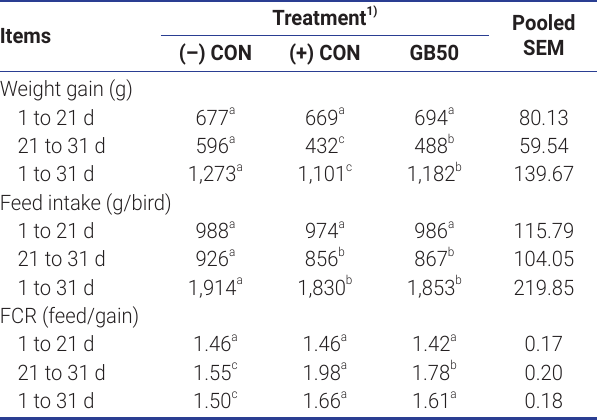
Table 7. Growth performance, feed intake and feed conversion ratio of broiler chickens in overcrowding and diurnal temperature range